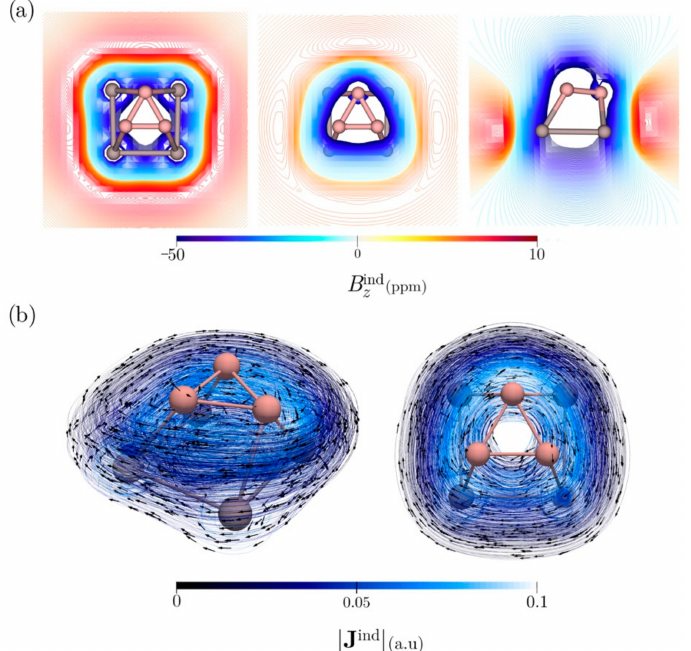
Figure 5. ( a ) B ind z isolines plotted in the plane of the Al 4 framework ( left ), the B triangle ( middle ), and in a transverse plane ( right ) to B 3 Al 4 + . ( b ) J ind vector maps plotted near B 3 Al 4+ . The